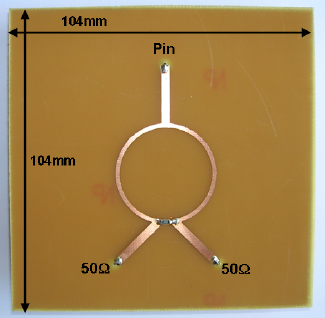
Figure 10: Photograph of the device under test: planar Wilkinson power